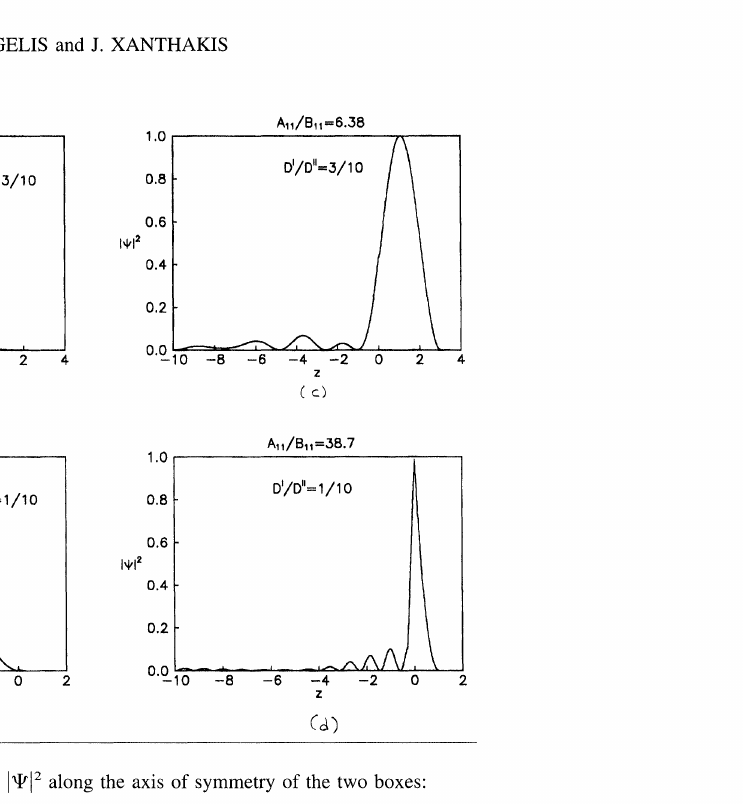
FIGURE 4 Charge density along the axis of symmetry of the two